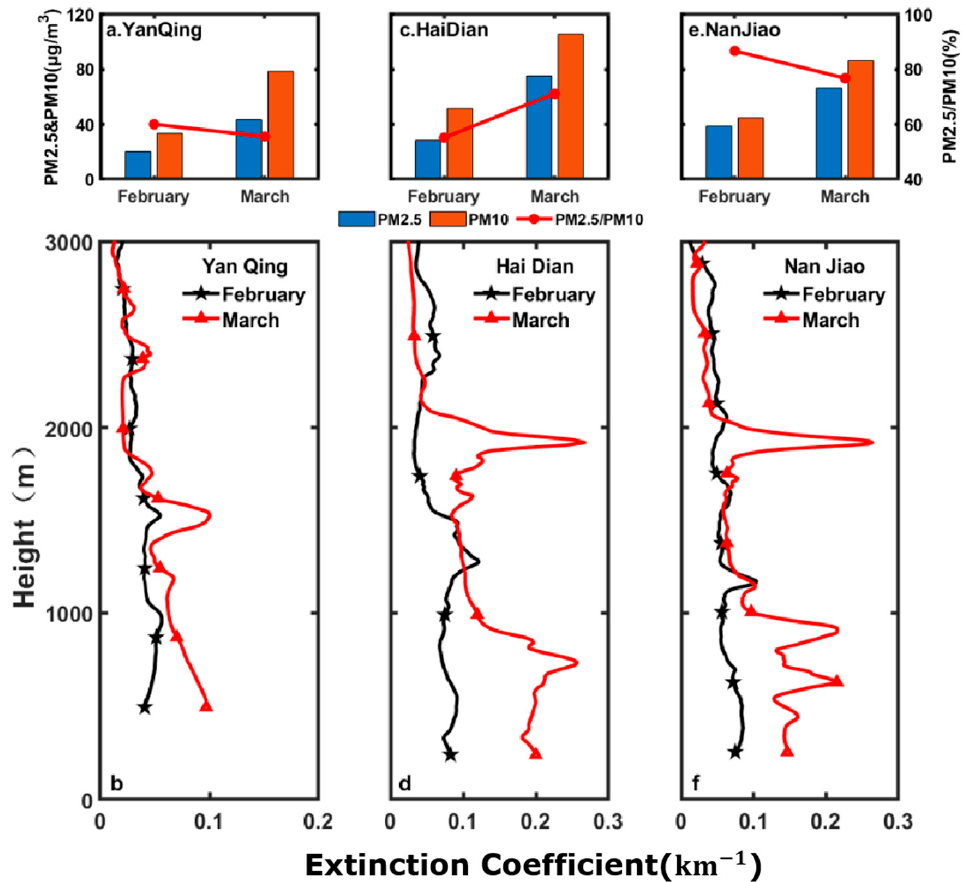
Figure 4. Monthly averaged PM data and extinction coefficient profiles at each station during the Winter Olympics.